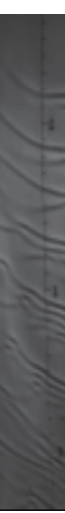
Figure 4: Two-dimensional regular wave packet, 𝛽 = 13 ∘ and Re = 32